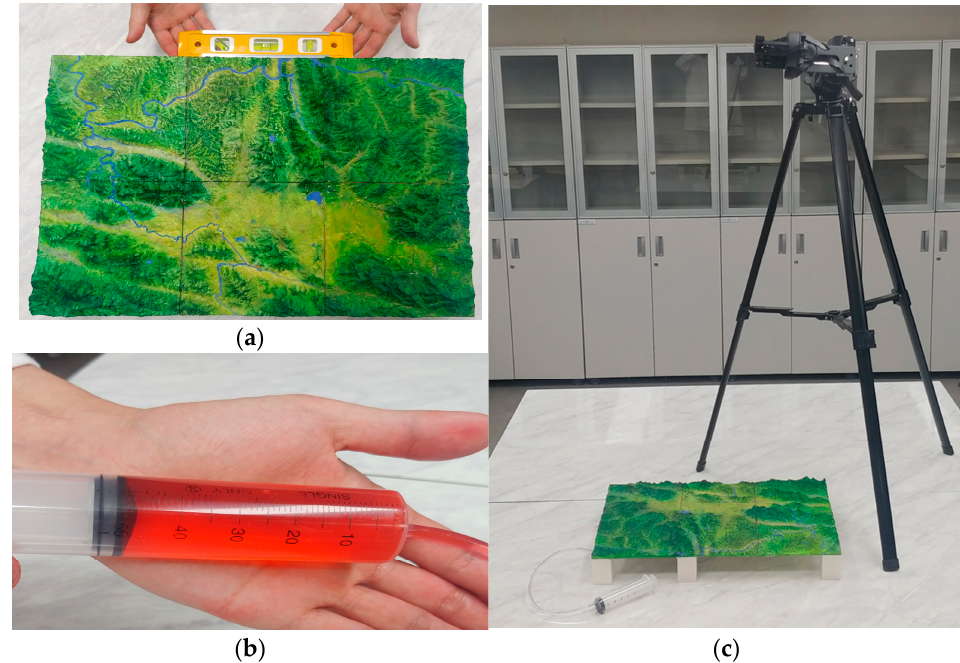
Figure 4. Experimental procedure: ( a ) level check of the 3D terrain model; ( b ) initial conditions of the syringe filled with 50 mL of mixed ethanol; ( c ) composition of the experimental shoot for video recording.